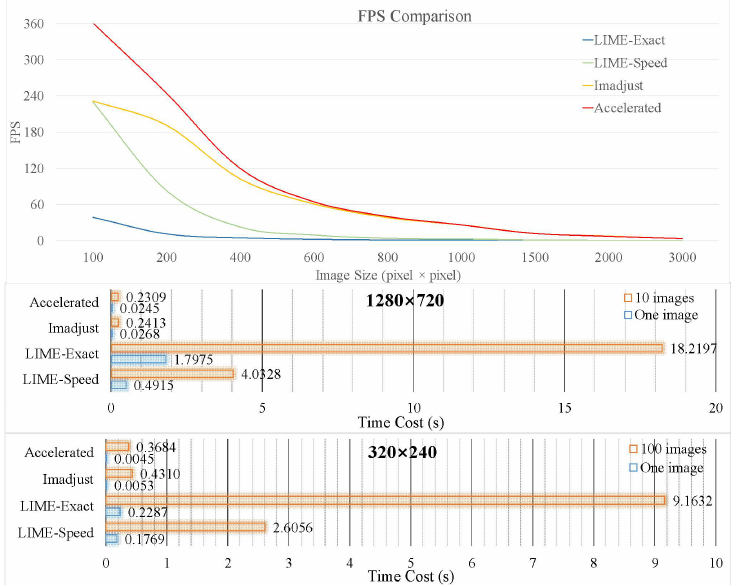
Figure 10. Comparison of the FPS of the algorithms and the cost of several image enhancement methods with different image sizes.